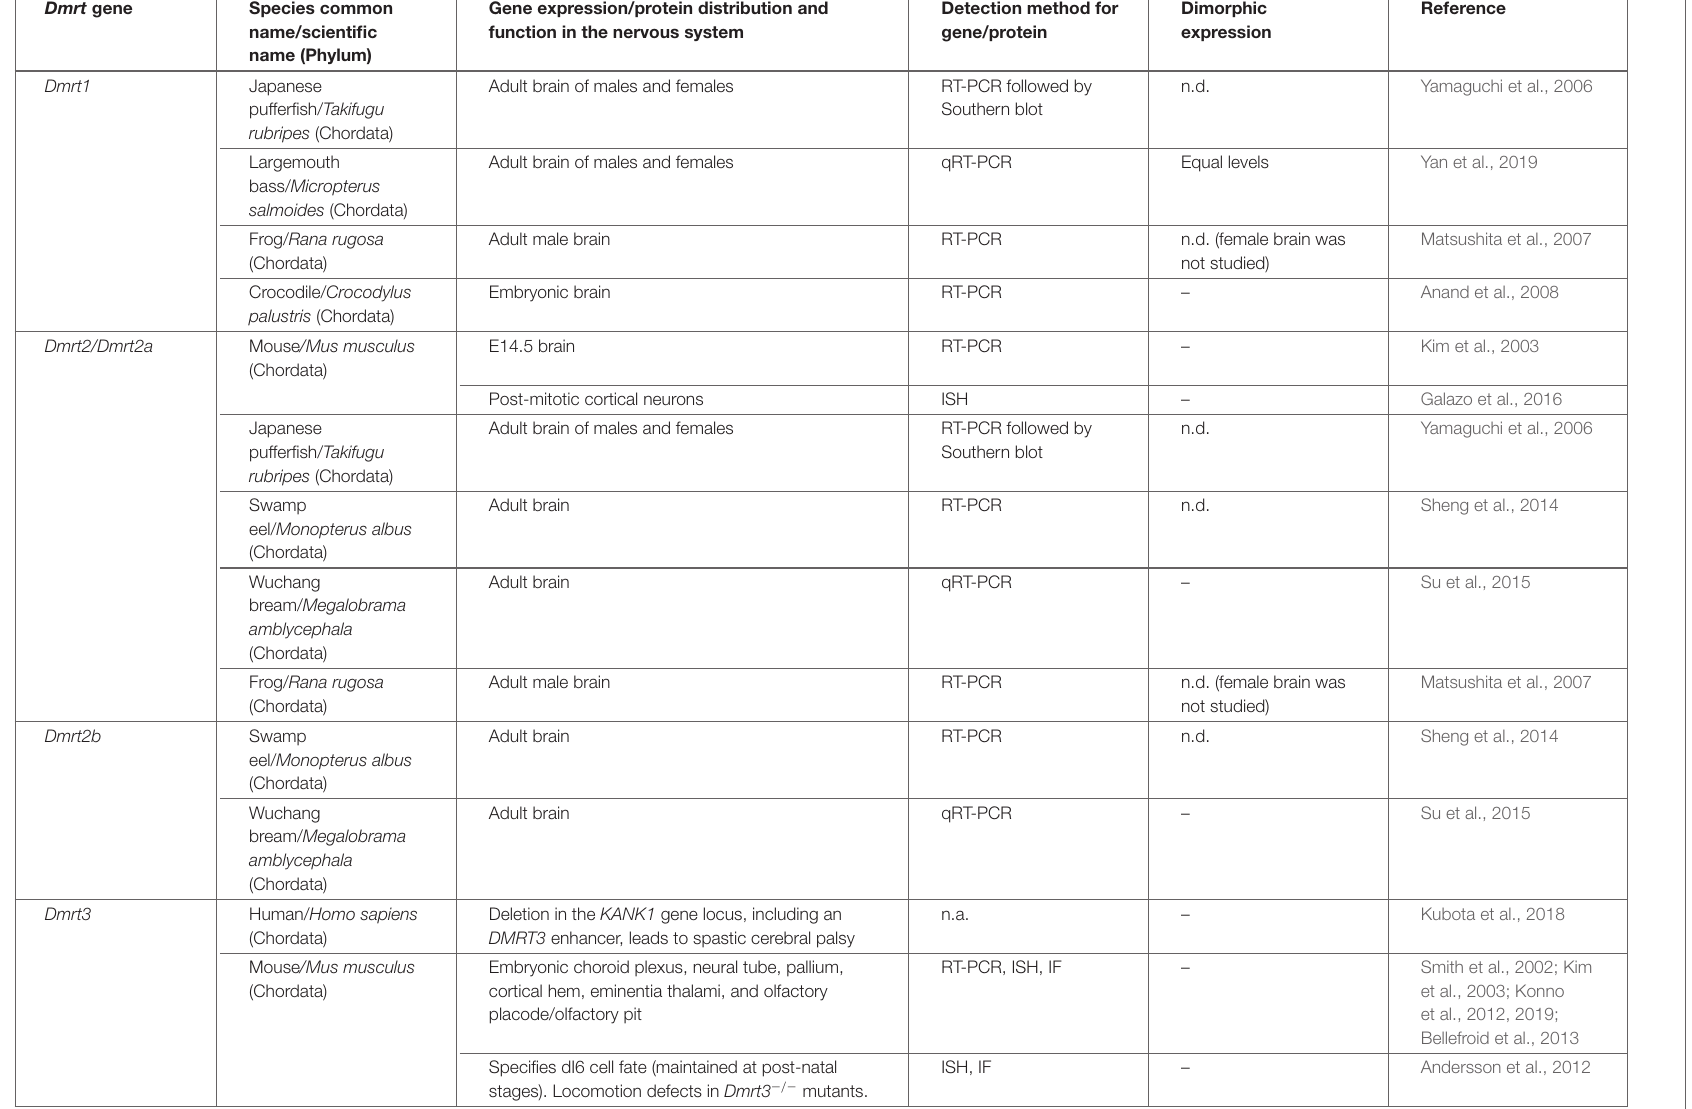
TABLE 1 | Dmrt gene expression and function in the nervous system of diverse metazoan groups. Dmrt